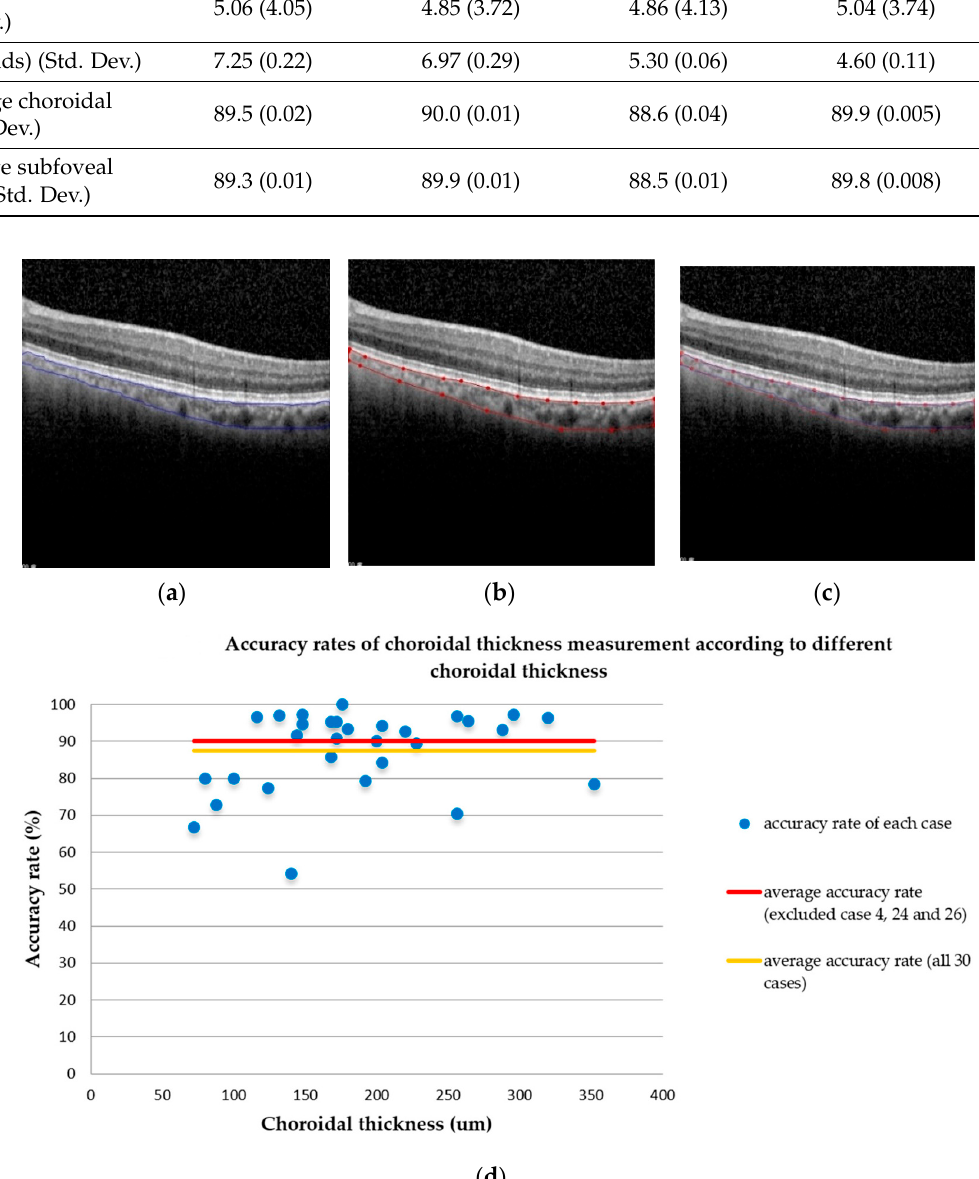
(pixels) (Std. Dev.) Average execution time (seconds) (Std. Dev.) thickness (%) (Std. Dev.) choroidal thickness (%) (Std. Dev.) (%) (Std. Dev.)